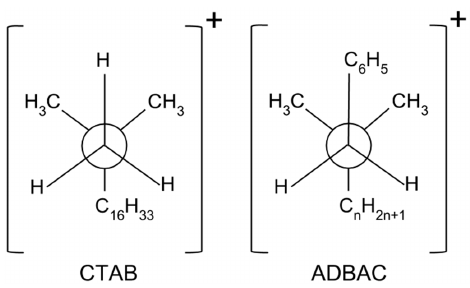
Figure 5. Newman projections of the surfactants (central circles indicate nitrogen atoms). CTAB: Figure cetyltrimethylammonium bromide; ADBAC: alkyldimethylbenzylammonium chloride.